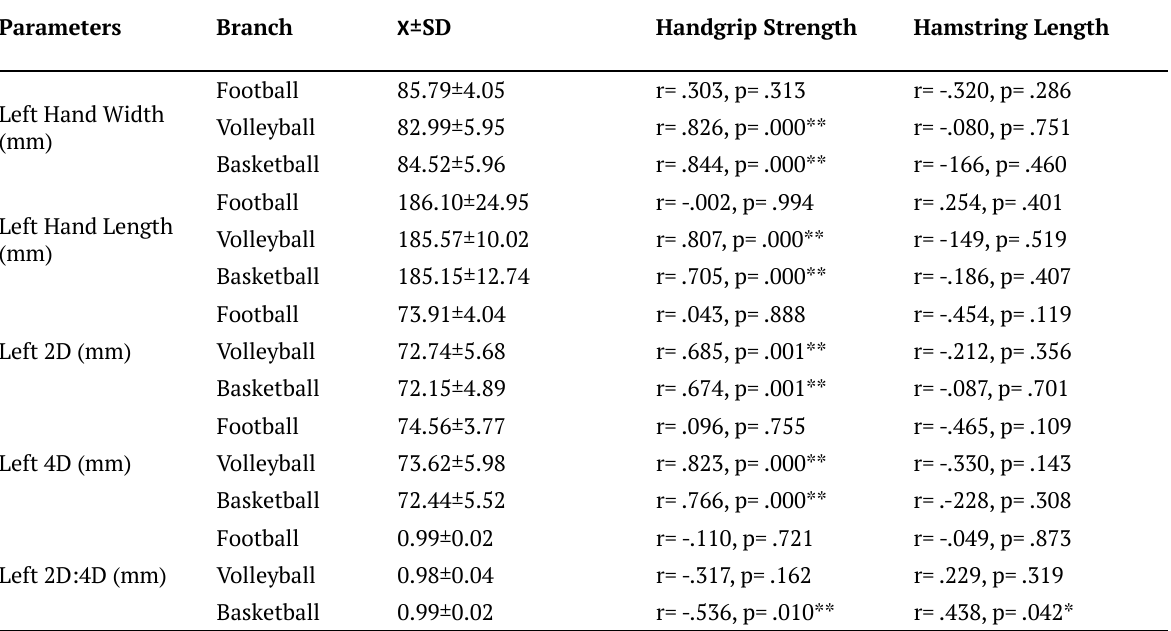
Table 3. The Relationship between the Hand Grip Strength and Hamstring Length of the Left